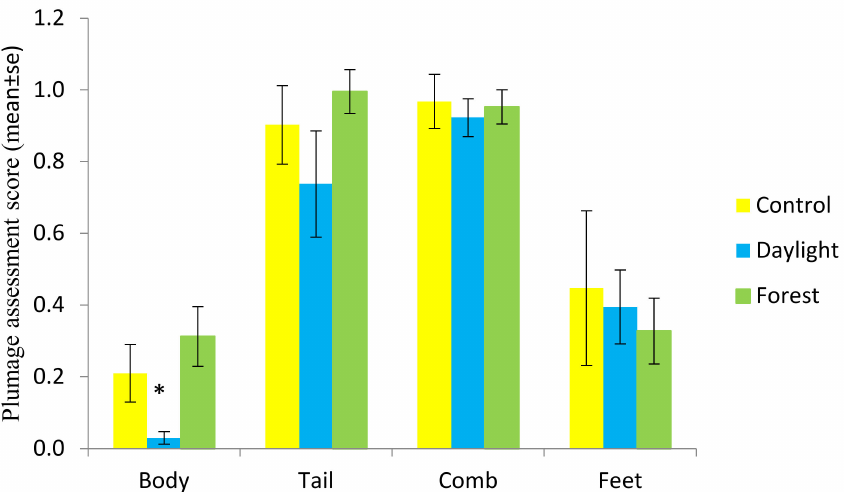
Figure 5. Plumage and integument assessment score (mean ± se) for the body, tail, comb and feet in the different light